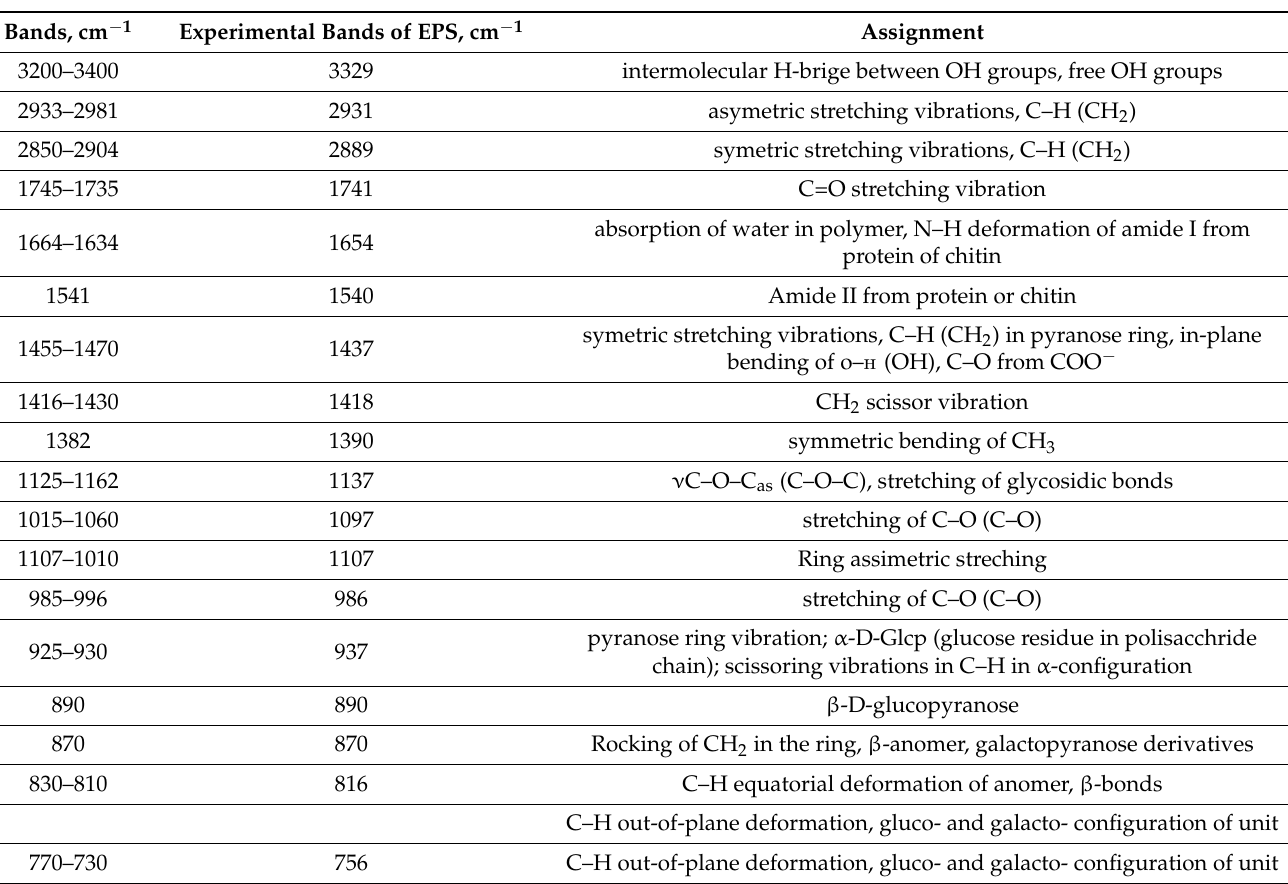
Table 5. Assignment of characteristic bands in FTIR spectrum of exopolysacchrides (EPS) from T. versicolor NBIMCC